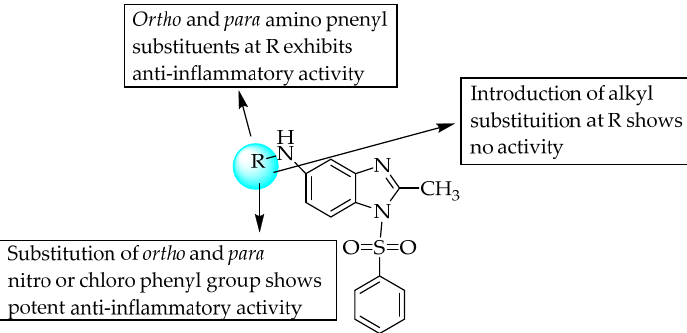
Figure 31 . SARs of 5-substituted-1-(phenylsulfonyl)-2-methylbenzimidazoles. Dunwel and his research team tried to evaluate the anti-inflammatory effects of a new series of compounds synthesised by the bio-isosteric replacement of benzoxazole with benzimidazole and benzothiazole, in the context of carrageenan-induced paw oedema in rats. The resulting compounds did not reduce rat paw oedema; this may be due to lower solubility or altered drug–receptor interactions (Figure 32) [50]. Many researchers have tried to develop novel anti-inflammatory agents by introducing substituents simultaneously at C2 and C5 of benzimidazole. Evans et al., in 1996, taking benoxaprofen as a lead, synthesised 72 benzimidazoles and evaluated their anti-inflammatory activities in rat adjuvant arthritis [51]. Only two compounds—a compound with a diethylamino ethoxy moiety at the 6-position and a compound bearing a substitution with 1-methoxy ethyl at C5 of benzimidazole—were comparable to indomethacin, with 43 and 33% improvement, respectively (Figure 33). In 2004, Terzioglu et al. introduced VUF6002 (Figure 34), a potent anti-inflammatory agent with strong antinociceptive effects, using JNJ7777120 (Figure 34) as a lead [52].